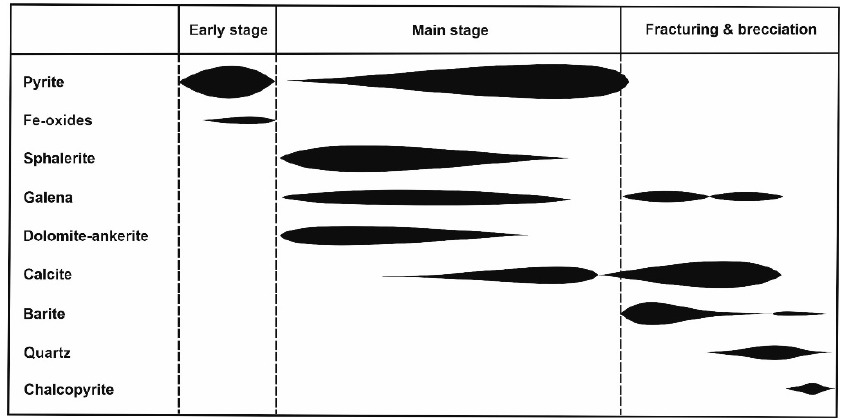
Figure 6. Paragenetic sequence of major minerals of the Castellanos Zn-Pb deposit.